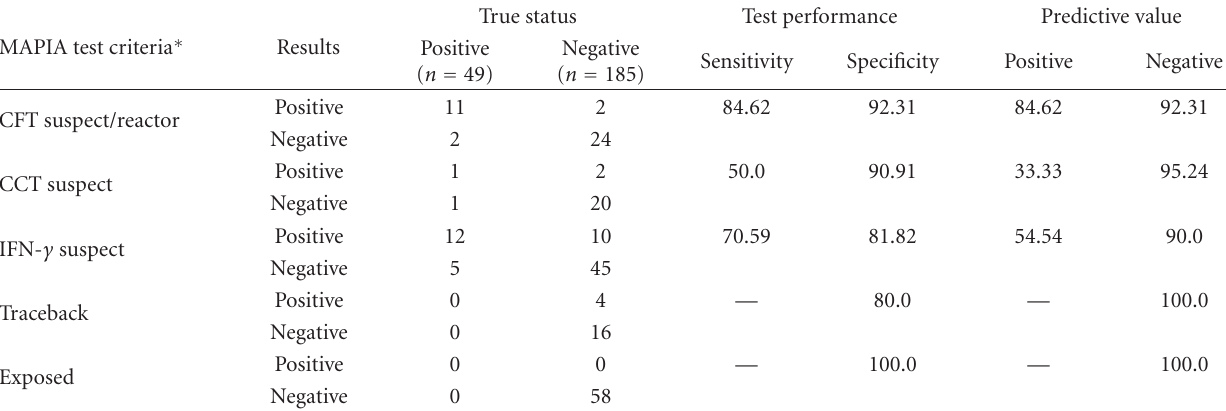
Table 2: Sensitivity, specificity, positive predictive value, and negative predictive value of a weak or strong positive reaction to at least three antigens (criterion 3) in the MAPIA test, by di ff erent antecedent tests.